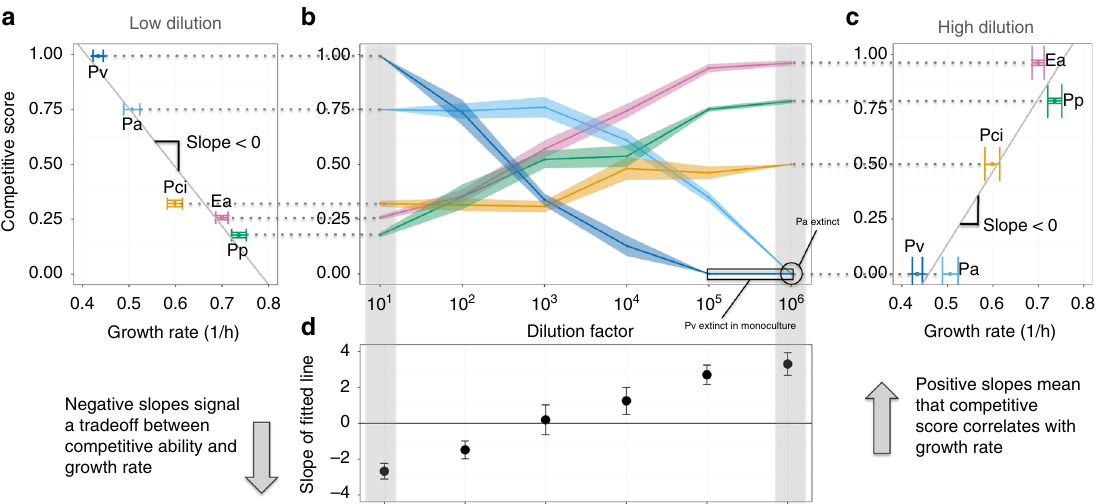
Fig. 4 Tradeoff between growth and competitive ability leads to dependence of experimental outcome on dilution factor. The LV model predicts that increasing dilution will favor faster-growing species over slower-growing ones. If fast growers dominate at low dilution factors, though, no changes in outcome will be expected. Changes in outcome are therefore most dramatic when slow growers are strong competitors at low dilution, exhibiting a tradeoff between growth rate and competitive ability. a This tradeoff was pervasive in our system: slower growth rates resulted in higher competitive scores at the lowest dilution factor. Growth rate was calculated with OD600 measurements of the time taken for monocultures to reach a threshold density within the exponential phase; error bars represent the SEM of replicates ( n = 21, per species) (Supplementary Fig. 3). Competitive score was calculated by averaging fraction of a given species across all pairwise competitive outcomes; error bars were calculated by bootstrapping, where replicates of mean experimental outcomes of a given pair were sampled 5000 times with replacement ( n = 34, per species, per dilution factor). b The competitive scores in a are extended to all dilution factors. The slowest grower ’ s score monotonically decreases with dilution, while the fast growers ’ scores increase, and an intermediate grower peaks at intermediate dilution factor. A similar pattern was seen in data from experiments in a complex growth medium (Supplementary Fig. 7). c At high dilution factors, the order of scores is reversed. d At low dilution factors 10 and 10 2 , competitive ability is negatively correlated with growth rate; the correlation becomes positive above dilution factor 10 3 . Error bars are the standard error coef fi cients given by the linear regression function lm in R. Source data are provided as a Source Data fi